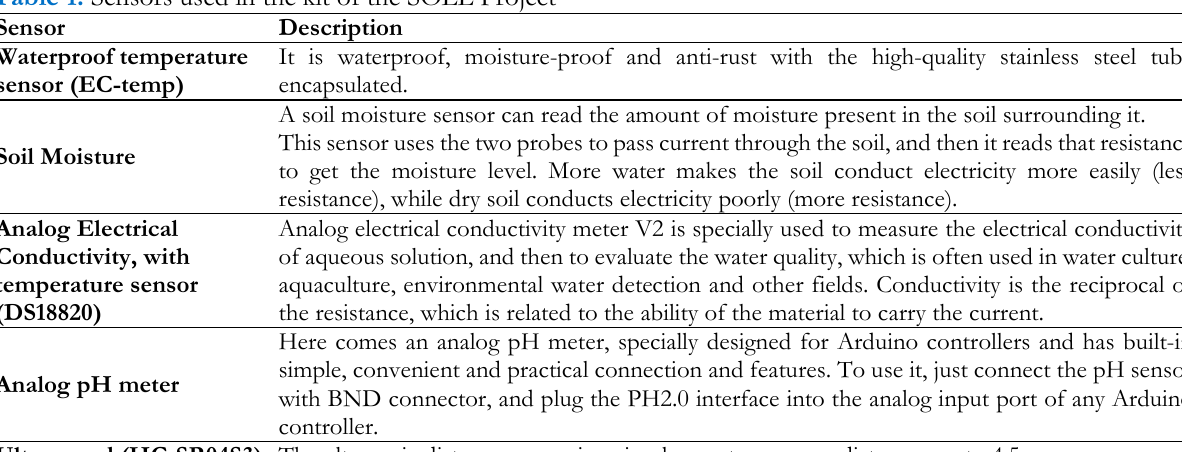
Table 1. Sensors used in the kit of the SOLL Project Sensor